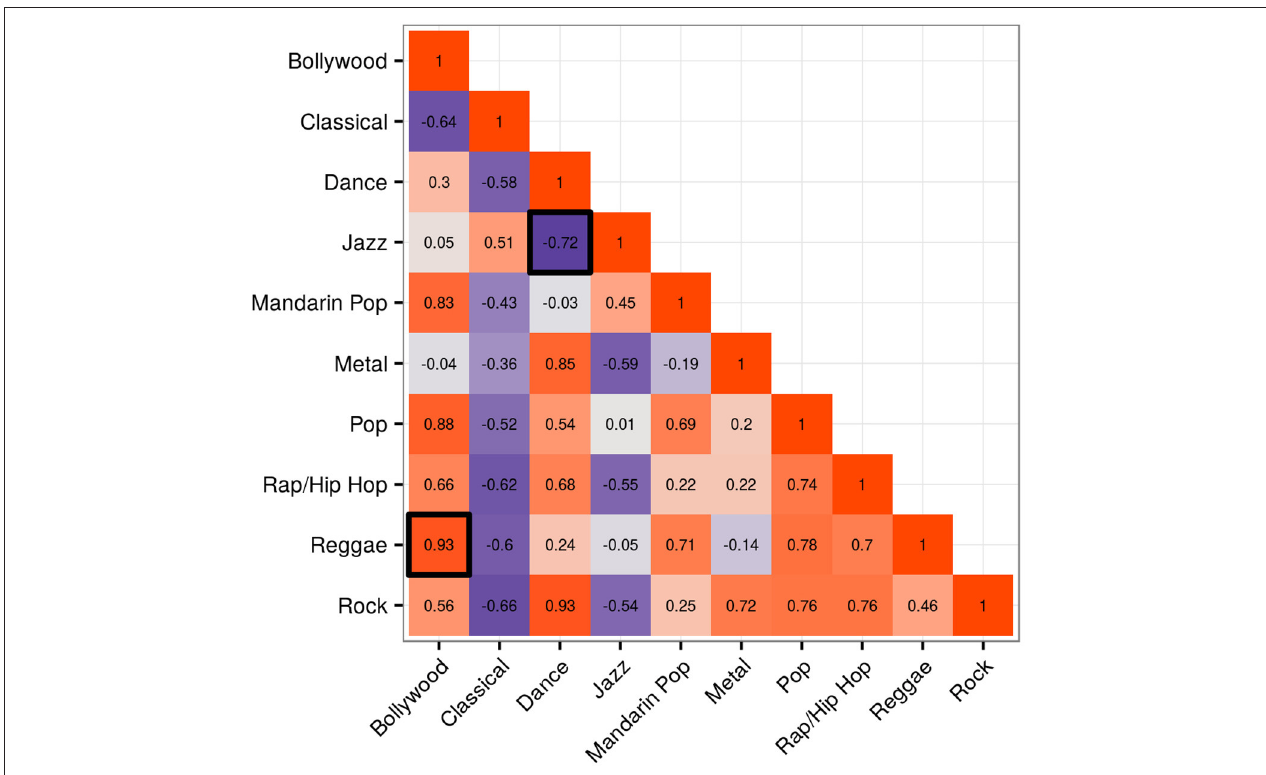
FIGURE 3 | Correlation matrix for Energy showing coefficients between pairs of X-head subgroups. The two highlighted cells relate to the solid lines in Figures 1 , 2 , Dance and Jazz, and Bollywood and Reggae